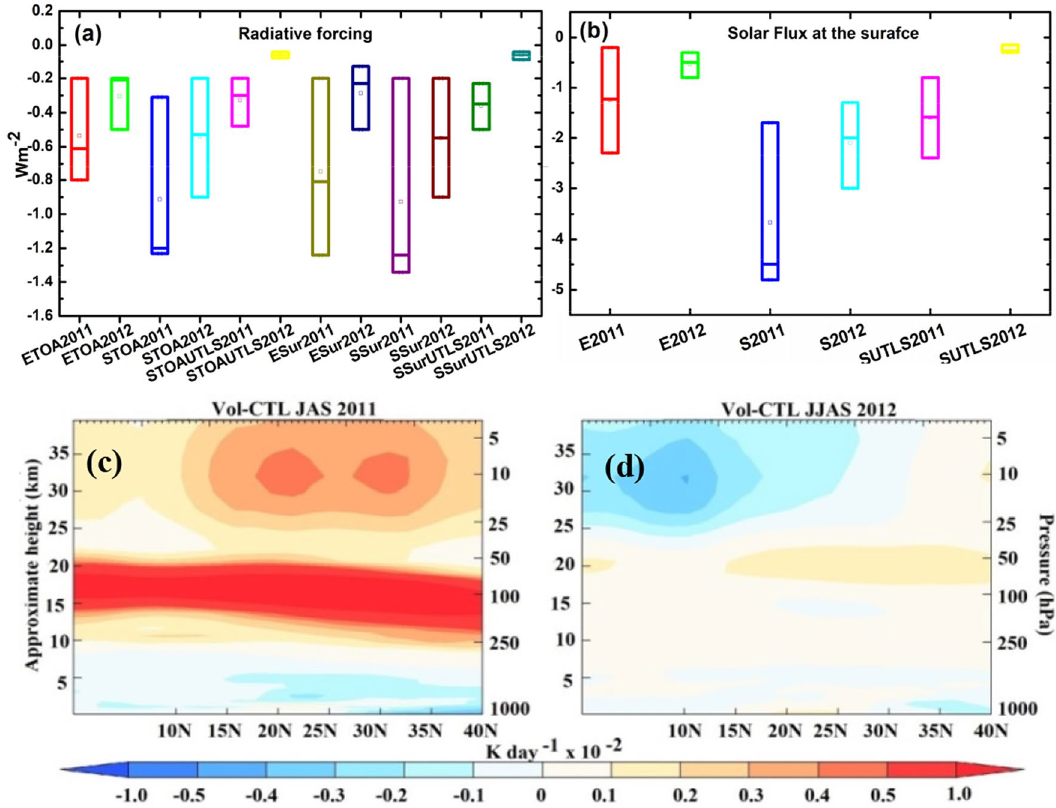
Figure 3. ( a ) Distribution of anomalies (Vol-CTL) in net direct radiative forcing at TOA (Wm −2 ) and